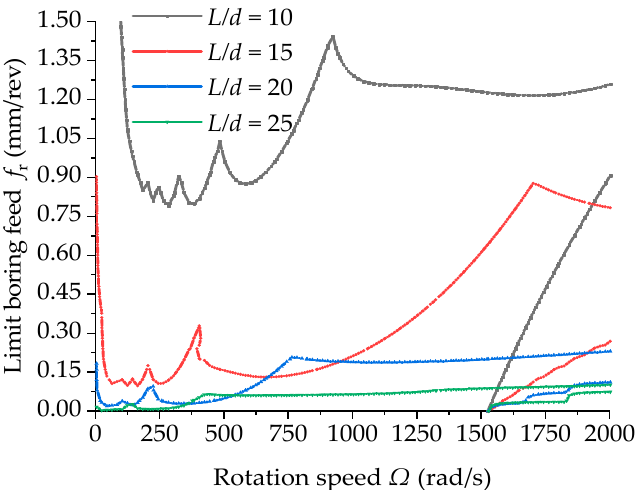
Figure 14. Stability lobe diagrams of the boring bar with different length-to-diameter ratios ( ψ = 1 and TR = 0).